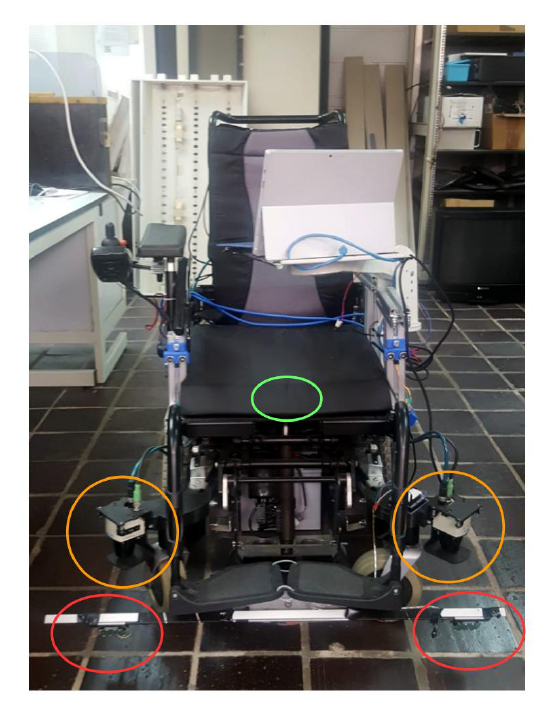
Figure 1. The intelligent wheelchair prototype with the set of lidar, odometer, IMU and Doppler